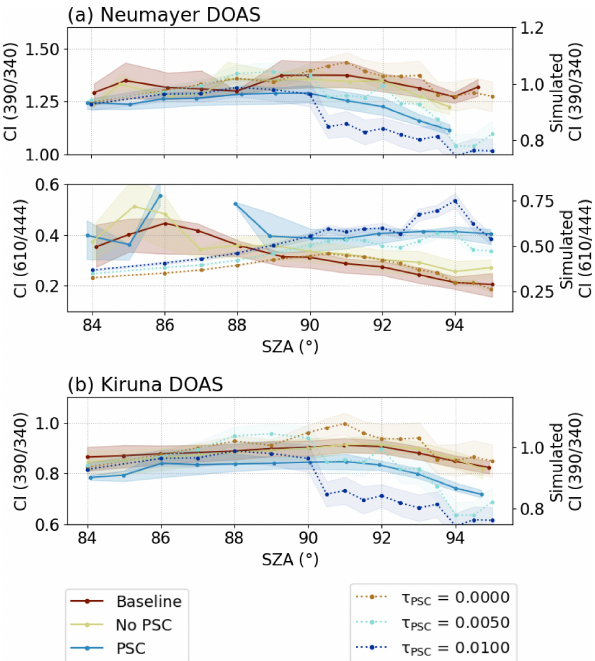
Figure 6. The average CI is depicted for the baseline (red) as well as PSC (blue) and non-PSC (greenish) cases for the measurements at both stations. For the Neumayer station (a) , the upper panel shows data in the UV and the lower panel in the visible spectral range. The baseline refers to data from February to April, while for the Kiruna station (b) it refers to data from July to October. Shading indicates the lower to upper quartile values of the data. Additionally, simulation results are depicted (dashed lines) for different optical depths τ PSC at h PSC = 20 to 22km. Here, shading indicates the 2 σ range of the results.